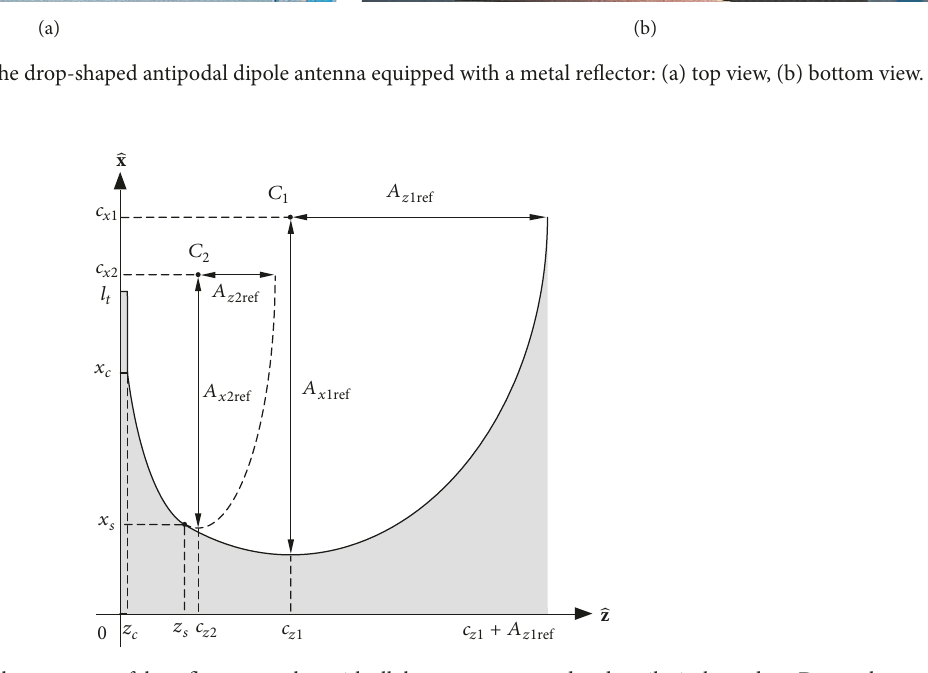
Figure 3: Schematic showing the geometry of the reflector together with all the parameters used to describe its boundary. Due to the structure symmetry, only the region for 𝑧 > 0 is shown in the